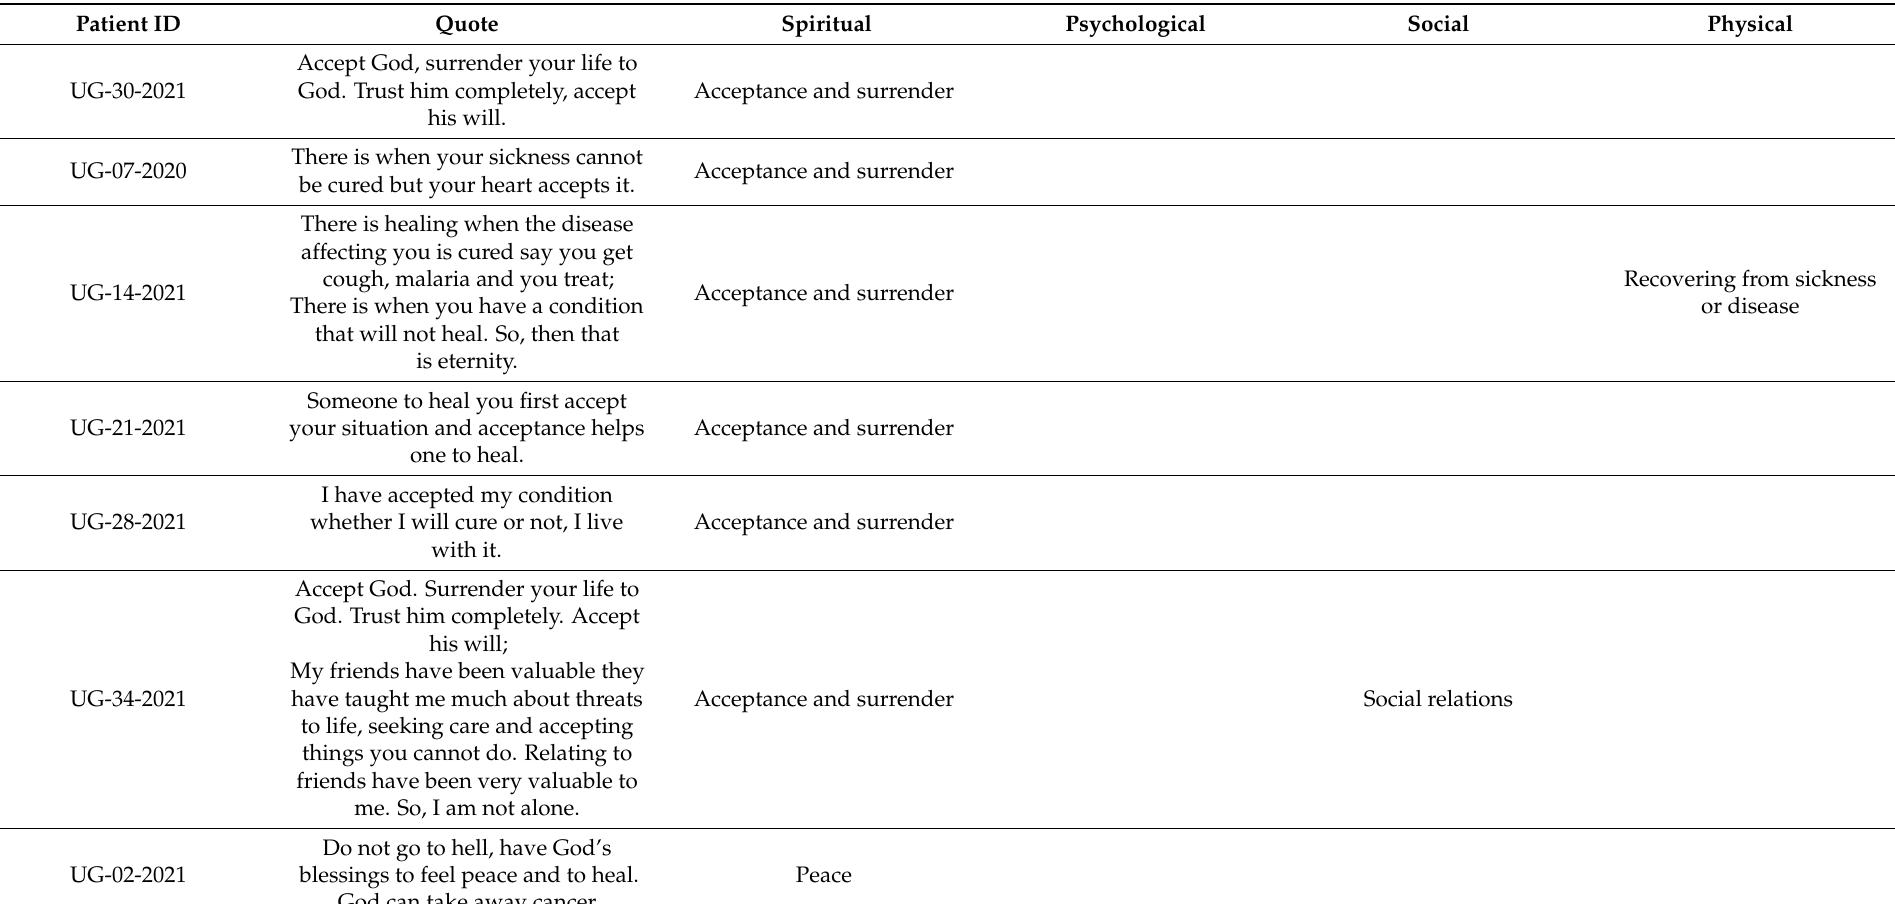
Table 2. Mapping of the patient descriptions of healing on to the multi-dimensional domains of Health ( n = 31 *). Patient